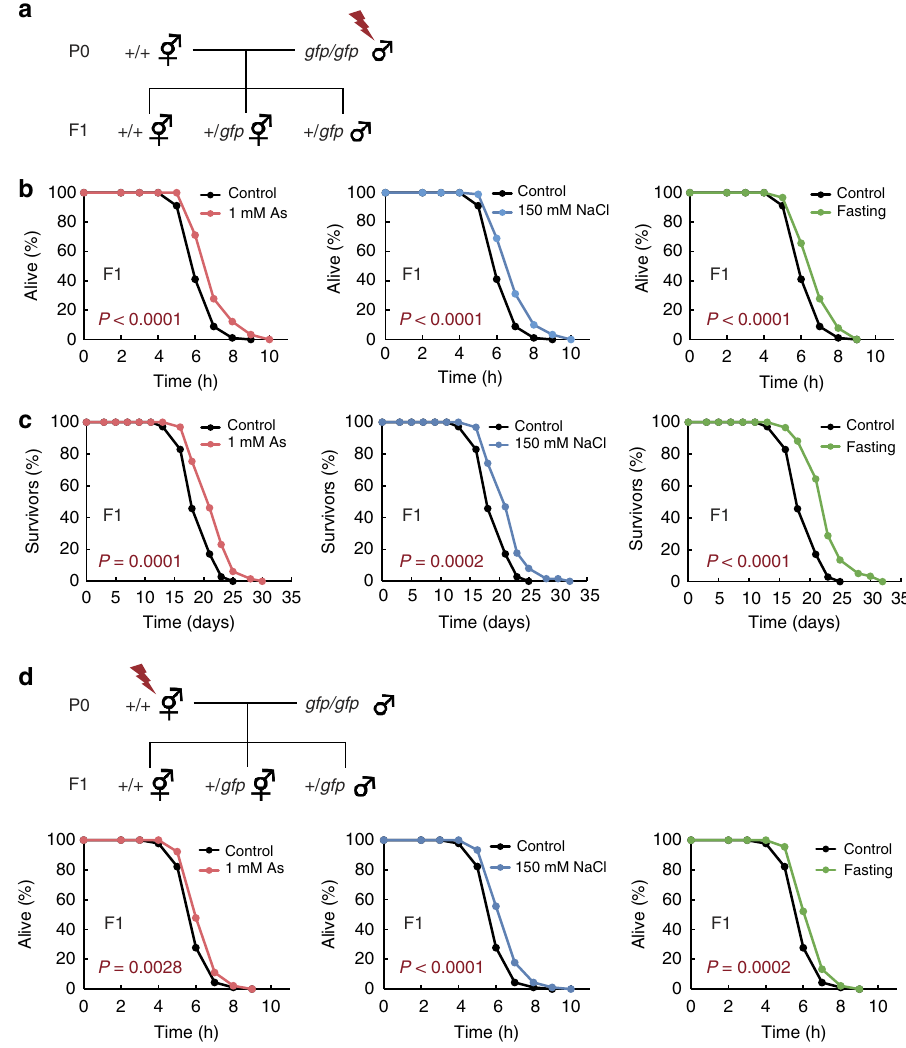
Figure 3 | Paternal and maternal inheritance of hormesis effects. ( a ) Scheme for isolation of the crossed F1 descendants whose male parents are subjected to stressors. GFP expression allows us to distinguish the crossed F1 descendants from the self-fertilized ones. ( b ) Oxidative stress resistance (2.3mM H 2 O 2 ) of the crossed F1 descendants on day 1 adulthood compared with control groups. Three independent experiments are integrated into each survival curve ( n ¼ 90). ( c ) Lifespan of the crossed F1 descendants. Representative data of seven independent experiments are shown. ( d ) Scheme for isolation of the crossed F1 descendants whose hermaphrodite parents are subjected to stressors (upper). Oxidative stress resistance (2.3mM H 2 O 2 ) of the crossed F1 descendants on day 1 adulthood compared with control groups (lower). Three independent experiments are integrated into each survival curve ( n ¼ 90). Mean lifespan and statistics are presented in Supplementary Tables 1 and 3. P values were calculated by log-rank